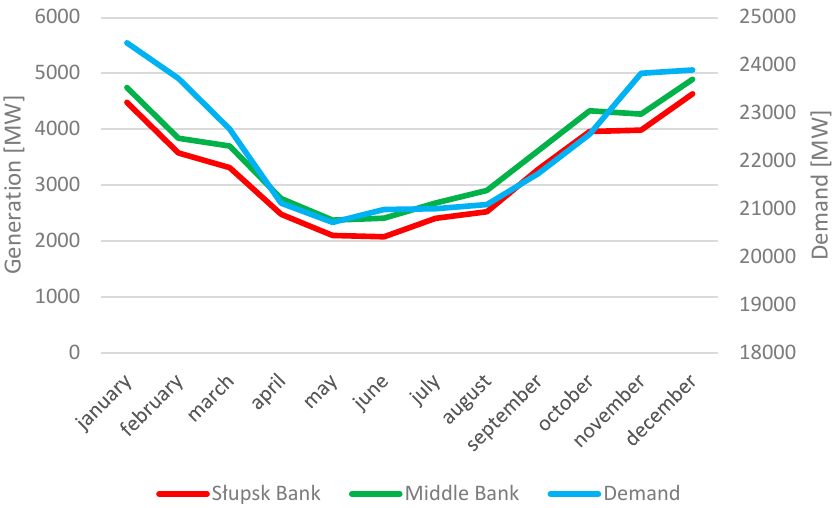
Figure 3. Correlation between the generation and the demand for power.